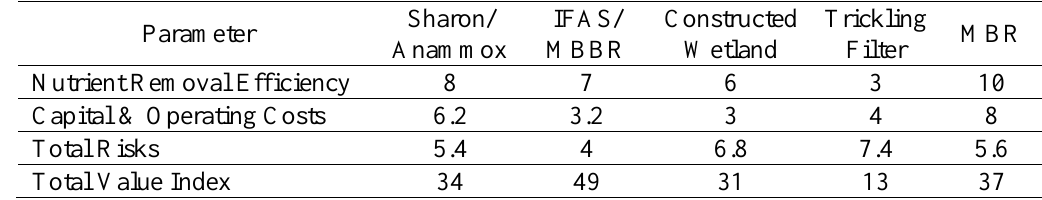
Table 4. Total value assessment of each process